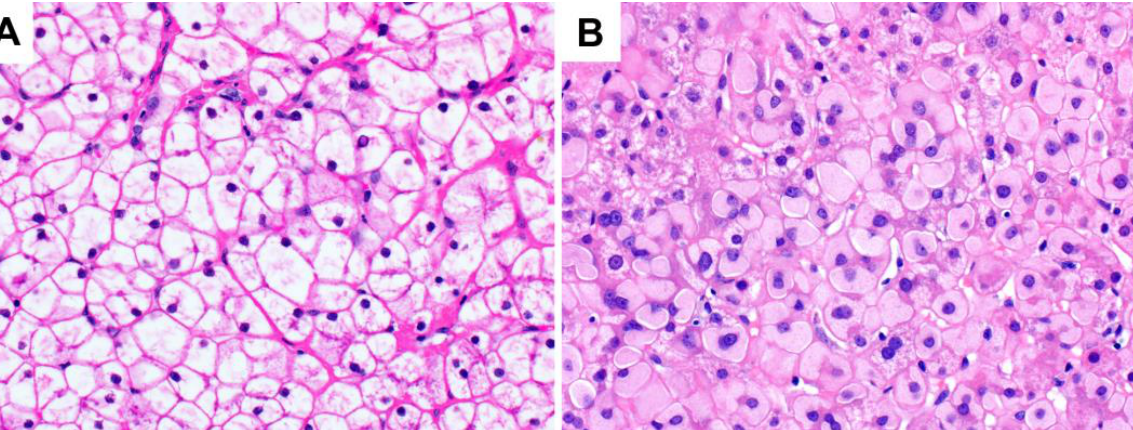
Figure 5. Glycogen storage disease (original magnification 400×): ( A ) type IX, with a similar histological appearance to glycogenic hepatopathy; ( B ) type IV, demonstrating hepatocellular ground-glass type cytoplasmic inclusions. These PAS-positive inclusions may be diastase-resistant as they comprise amylopectin-like material rather than typical glycogen. Chronic hepatitis B infection and drug-induced glycogen pseudoground-glass type changes can have a similar appearance and should be excluded.